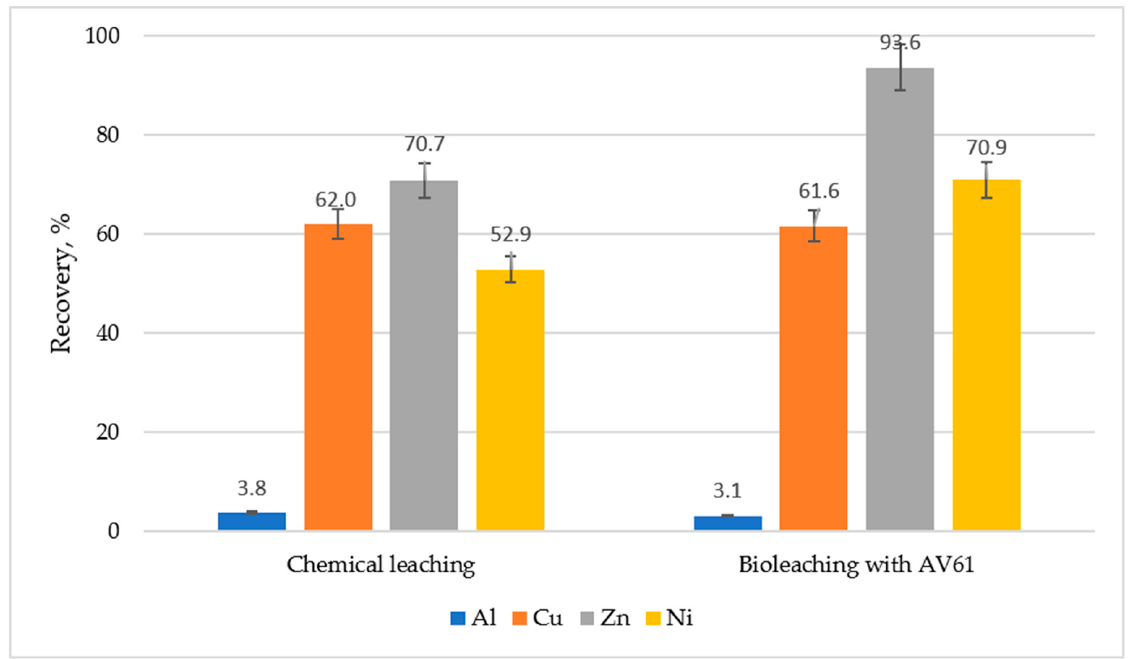
Figure 6. Recovery of metals from PCBs with two-stage leaching, 6 h duration (2 h + 4 h). (PD 10%; Fe 3+ concentration 16 g/L (chem) and 19 g/L (bio); initial pH 1.2; 40 °C; air 1 lpm; 600 rpm.)